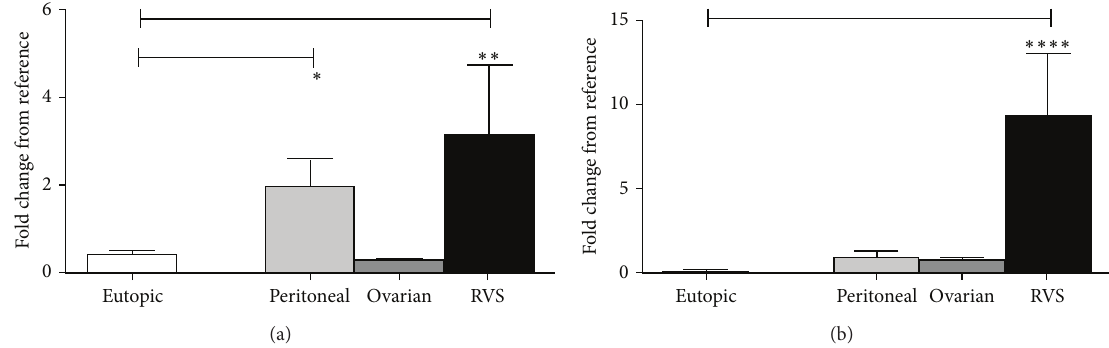
Figure 2: Inflammatory cytokine mRNA expression in eutopic and matching ectopic endometriotic lesions from different locations. (a) The mRNA expression of TNF 𝛼 was significantly higher in the peritoneal and RVS lesions compared to their matching eutopic endometrium. (b) The mRNA expression of IL-6 was significantly higher only in the RVS lesions. All values are represented by mean ± SEM. ∗ < .05 , ∗∗ < .01 , ∗∗∗∗ < .0001